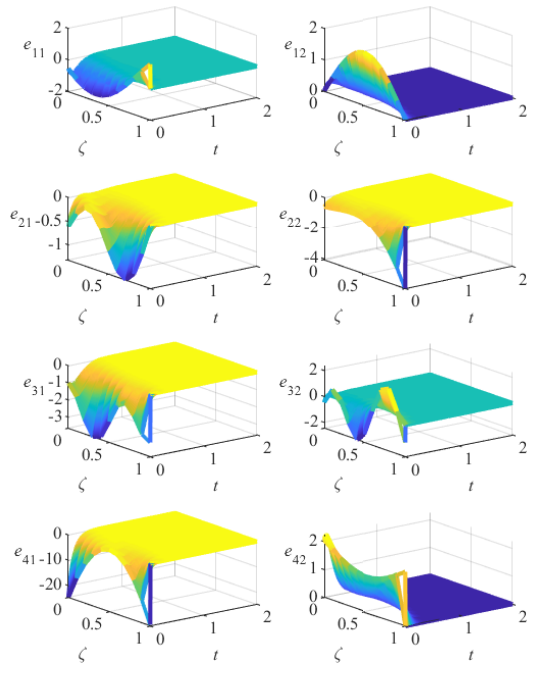
Figure 2. e ( ζ , t ) of HPDECSTN (1) with control.